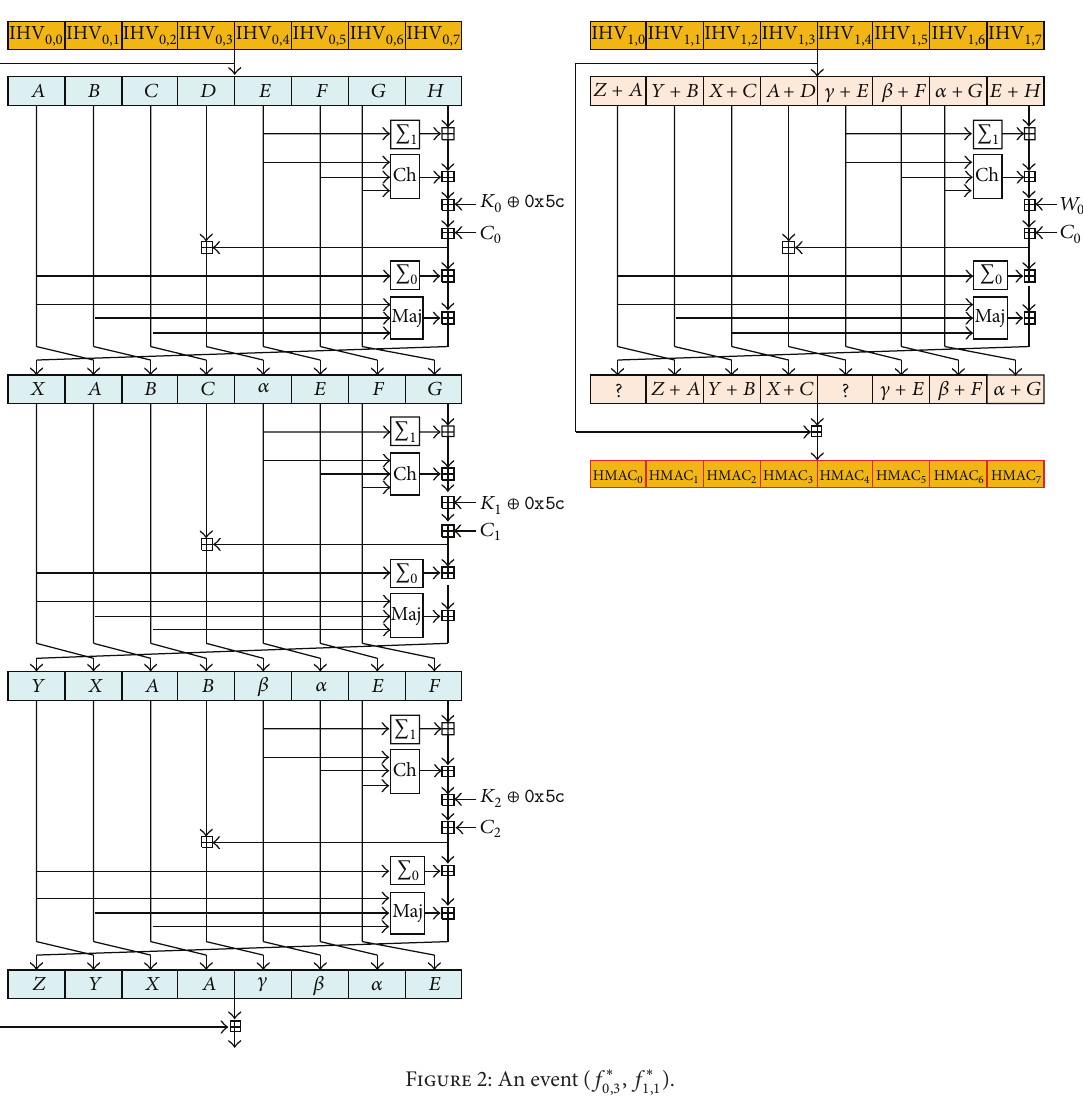
Figure 2: An event (𝑓 ∗ 0,3 , 𝑓 ∗ 1,1 ) .